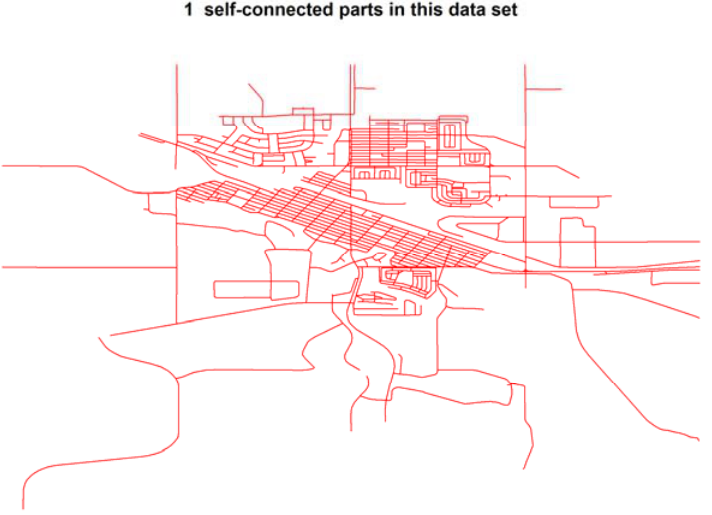
Figure 8. Connectivity of the Estevan road network with topology errors fixed via the function nt.connect.